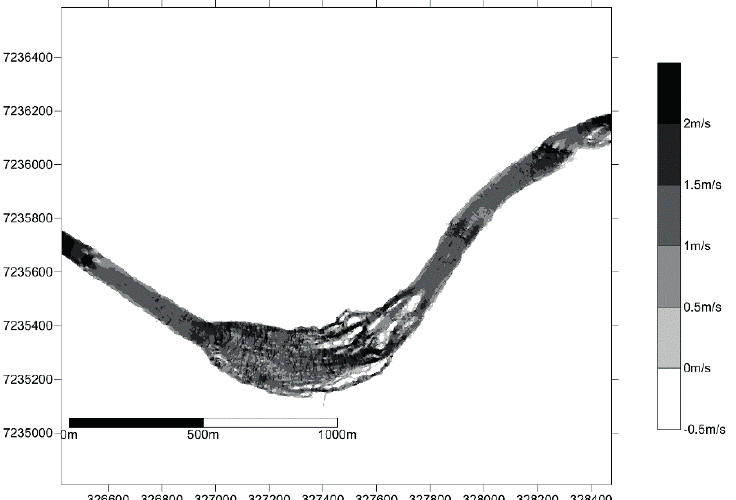
Fig. 5 Simulated flow velocities during a discharge of 500 m 3 s -1 for a mixed anastomosing reach of the Sabie River. More alluviated reaches occur both upstream and downstream; flow is left to